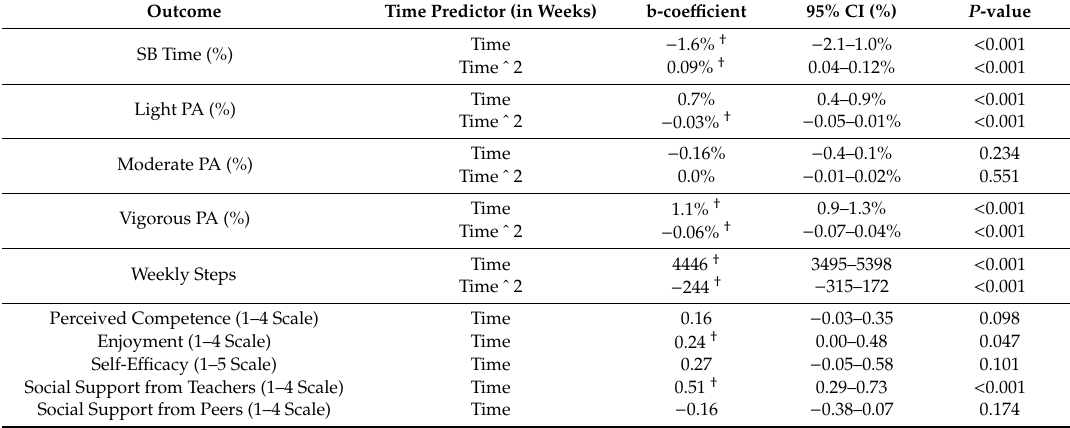
Table 2. Parameter estimates from the general linear mixed-e ff ects